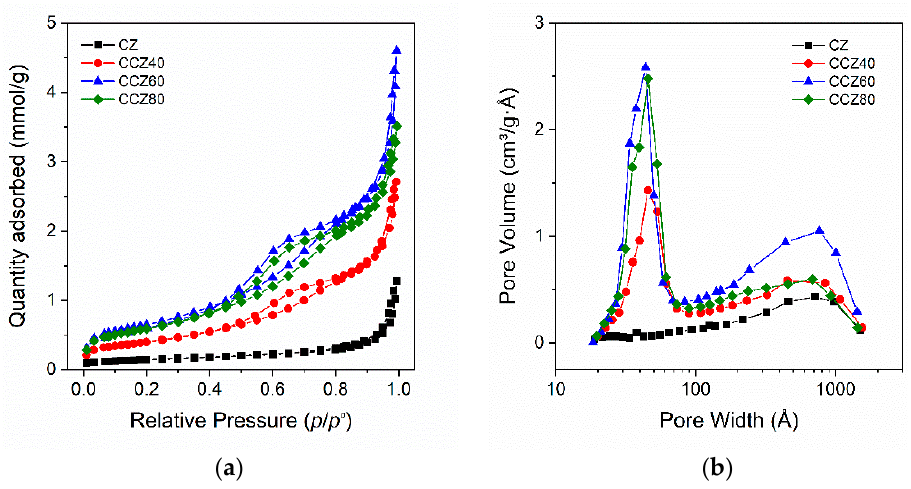
Figure 2. Textural characterization of as–prepared samples: ( a ) N 2 physisorption isotherms; ( b ) pore– size distribution by the BJH